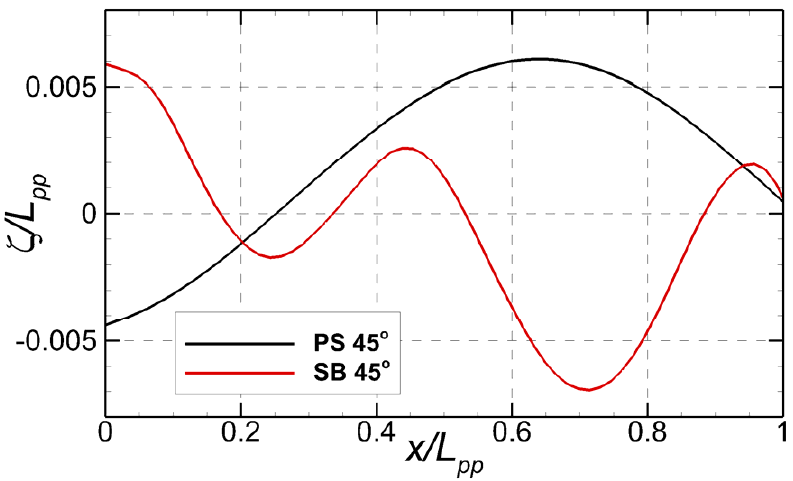
Figure 24. Wave profiles on the hull. Table 19. Harmonic amplitudes and phases of the total resistance coefficient ( C T ) for the FRxz ϕθ quartering waves scenario.